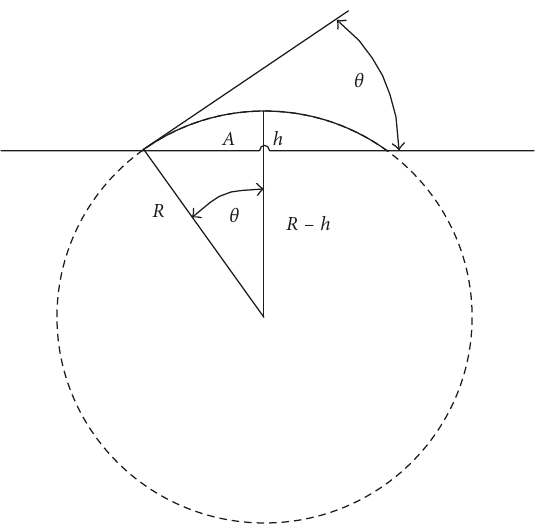
Figure 1: Contact angle